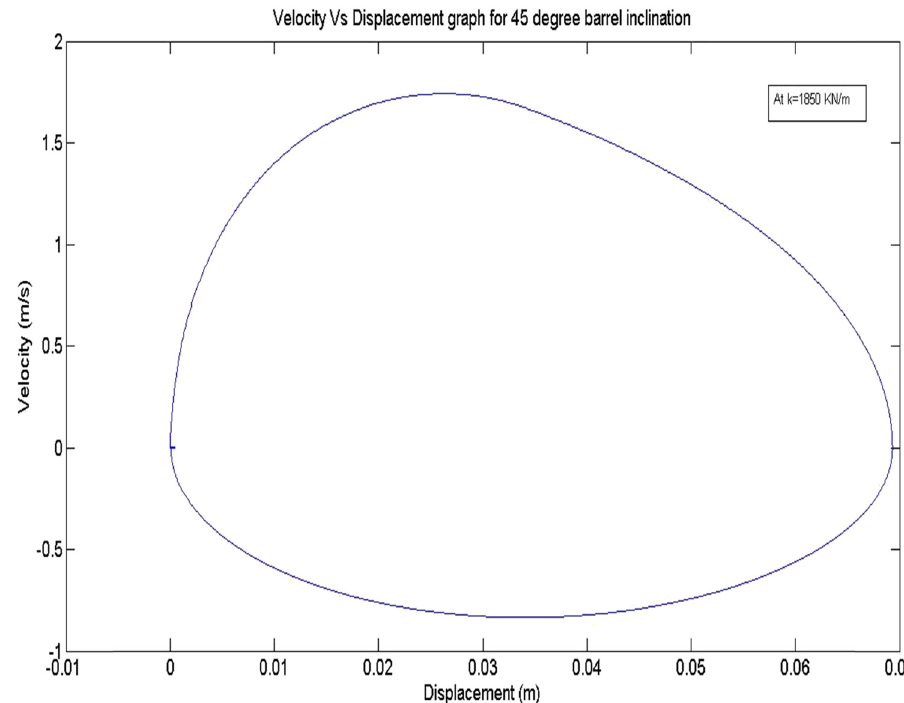
Figure 5: Velocity vs displacement at 45° fi ring angle.